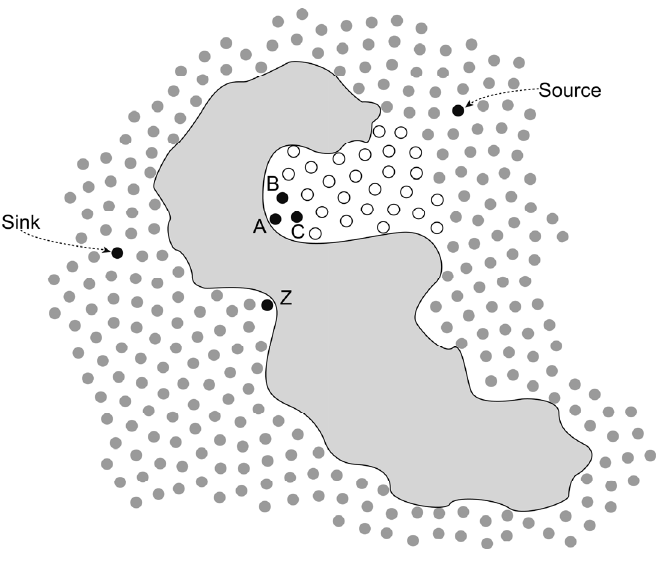
Figure 2. Construction of a forbidden region for a concave